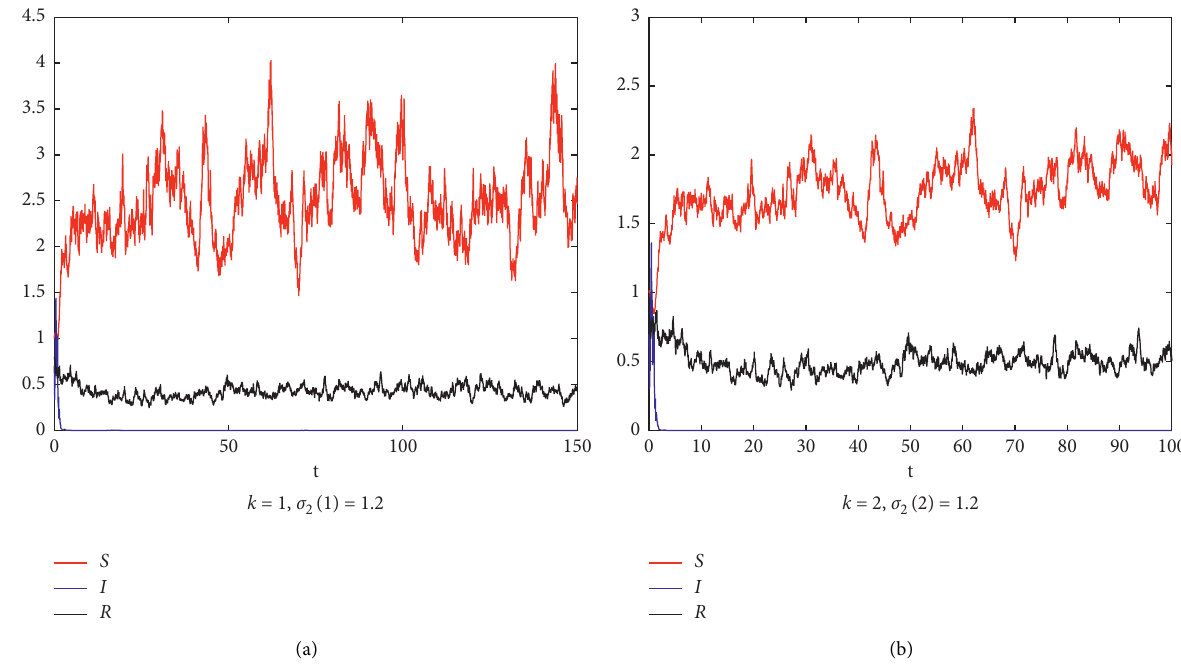
Figure 2: Simulations of the solution ( S ( t ) , I ( t ) , R ( t )) to stochastic model (2) with ( S ( 0 ) ,I ( 0 ) , R ( 0 )) � ( 1 , 0 . 7 , 0 . 8 ) . (a) k � 1 , σ ( 2 ) � 1 . (b) k � 2 , σ 2